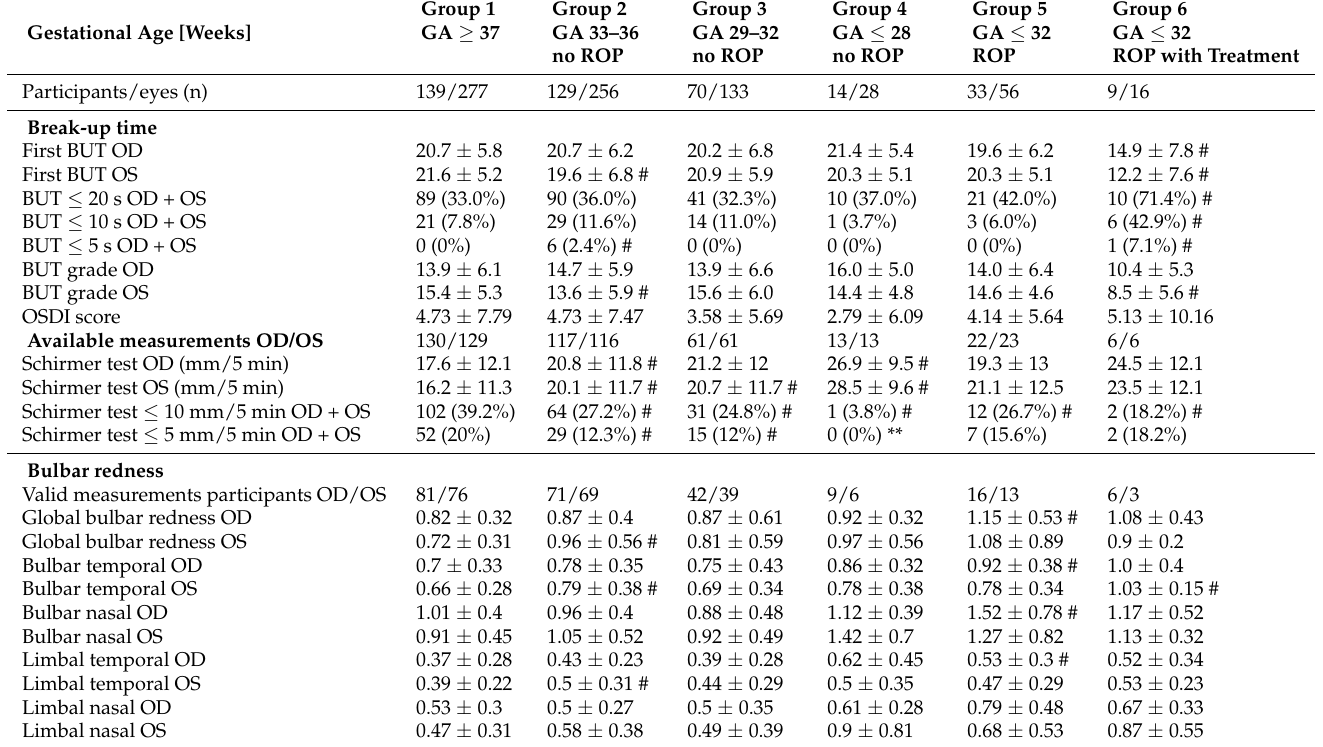
Table 2. Anterior segment parameters of the study groups.